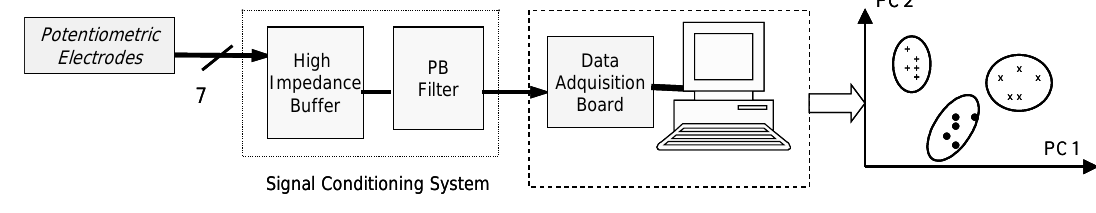
Figure 1. Block diagram of the electronic